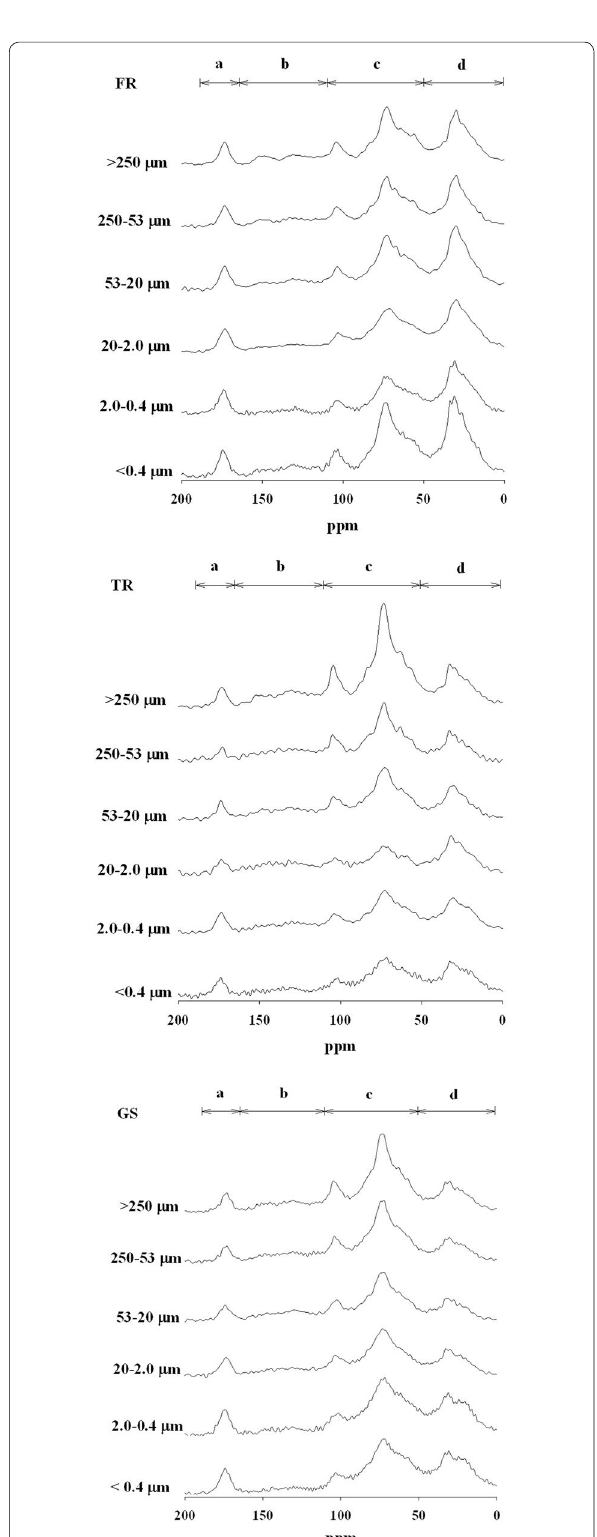
Fig. 2 CP/MAS 13 C NMR spectra in different particle‑size fractions in forest (FR), transition (TR), and grassland (GS) sites. a Carboxyl‑C, b aromatic‑C, c O‑alkyl‑C, d